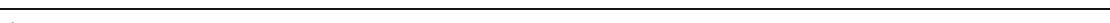
(See figure on previous page.) Fig. 1 PsBZP32 is a conserved bZIP transcription factor with an additional PAS domain. a Phylogenetic analysis of PsBZP32 and its homologues in oomycetes. Full-length amino acid sequences were used to generate the phylogenetic neighbor-joining tree in MEGA 6.0. b Protein sequence alignment of PsBZP32 and its homologs in Phytophthora ramorum , Peronospora tabacina , Pythium ultimum , and Saprolegnia parasitica . c Transcription pattern of PsBZP32 according to RT-qPCR. MY, SP, ZO, CY, and GC represent the asexual life stages of P. sojae : vegetative mycelia, sporangia, zoospores, cysts, and germinated cysts, respectively. IF1.5, IF3, IF6, IF12, and IF24 represent the infection stages of P. sojae : 1.5, 3, 6, 12, and 24 h post-infection (hpi), respectively. Relative transcription levels were calculated using the MY values as a reference. d Relative transcription levels of PsBZP32 in PsBZP32 -silenced transformants and control strains. WT, wild-type strain; CK, control strain transformed with empty vector. *, significant difference compared with the WT (two-tailed t -test, P <